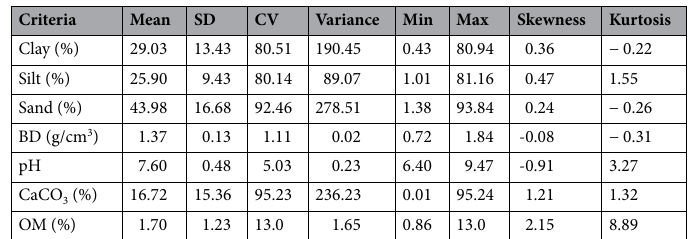
Table 5. Descriptive statistics some physico-chemical properties of soil samples. OM organic matter, BD bulk density, SD standard deviation, CV coefficient of variation, Min minimum, Max maximum.